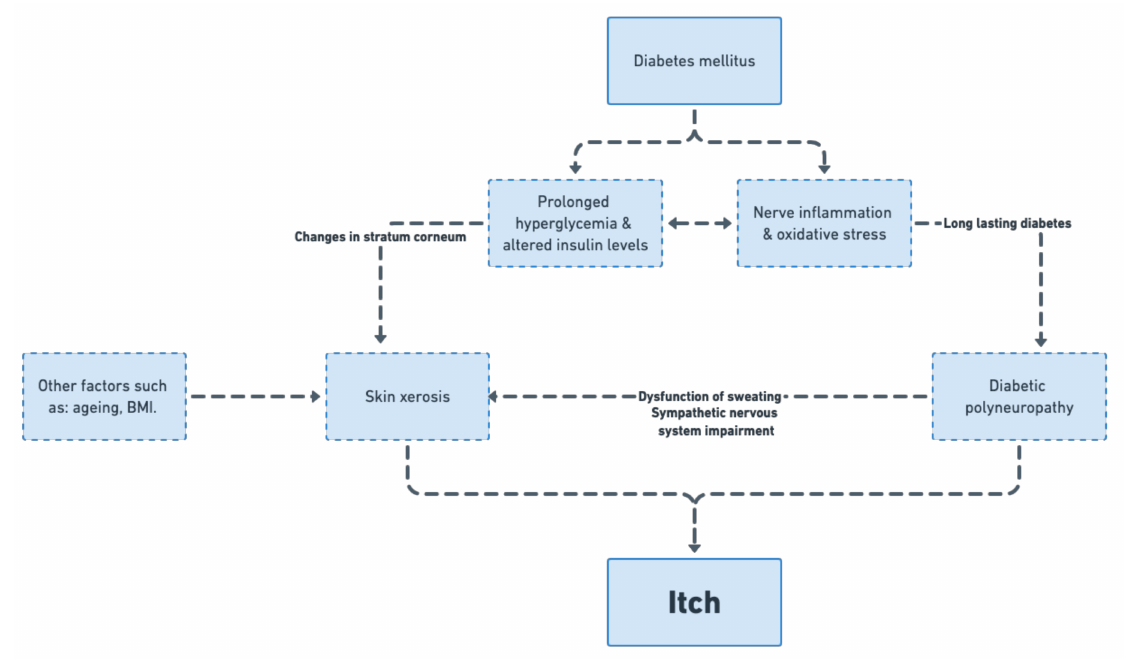
Figure 7. Proposed pathogenetic model of itch in